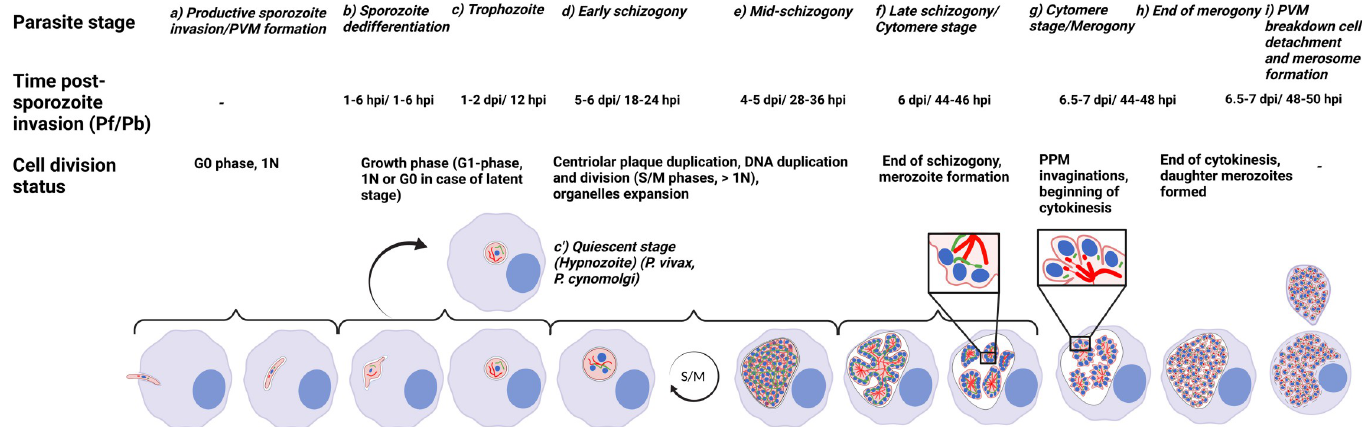
Fig 2. Schematic representation of Plasmodium cell division and development during the LS. Typical features and molecular details of P . falciparum and P . berghei ( Pf / Pb ) during the entire LS development are indicated as “Parasite stage” from (a) to (i) and the “Cell division status” section are indicated for each parasite stage. The duration of development “Time post-sporozoite invasion (Pf/Pb)” indicates the in vivo Plasmodium LS development. Horizontal brackets assemble drawings that represent the “Cell division status” of the parasite. (a) Upon productive invasion of a hepatocyte (light blue) the parasite (pink) resides within a PV surrounded by the PVM (light blue). Initially, the parasite remains in G0, 1N but expands in size. Parasite organelles are depicted as follows: nucleus (blue), apicoplast (green), and mitochondria (red). (b) The dedifferentiation phase starts when the crescent-shape sporozoite transforms into a bulbous-shaped form that finally becomes a circular EEF trophozoite expanding in size and entering the G1 phase (c) . (c’) A proportion of P . vivax and P . cynomolgi parasites do not develop further into schizonts but remain dormant (hypnozoite) as in G0 phase. (d) Schizogony is characterized by nuclei multiplication, and alternated DNA synthesis/mitosis (S/M) phases are triggered (DNA > 1N). (e) During the process of schizogony, mitochondrion and apicoplast grow into highly branched structures. (f) The cytomere stage initiates merogony (merozoite formation). The PPM invaginates and the still singular mitochondrion organizes as a finger-like structure. The apicoplast locates between the nuclei and the surrounding PPM within parasite cytoplasm (left panel in (f) ). Then, the apicoplast begins to form regular constrictions resulting in the fission of the organelle (right panel in (f) ). (g) At the end of the cytomere stage, mitochondrion fission occurs prior to cytokinesis as depicted in the zoomed section. (h) Tens of thousands individual merozoites are formed, depending on the Plasmodium species, with each containing an individual set of organelles; cytokinesis signifies the end of LS merogony. (i) Finally, PVM rupture liberates merozoites into the host cytosol followed by host cell detachment and merosome formation (indicated by the merozoite-filled vesicle on top of the detached cell (created with BioRender.com). EEF, exoerythrocytic form; LS, liver stage; PPM, parasite plasma membrane; PVM, parasitophorous vacuole membrane.